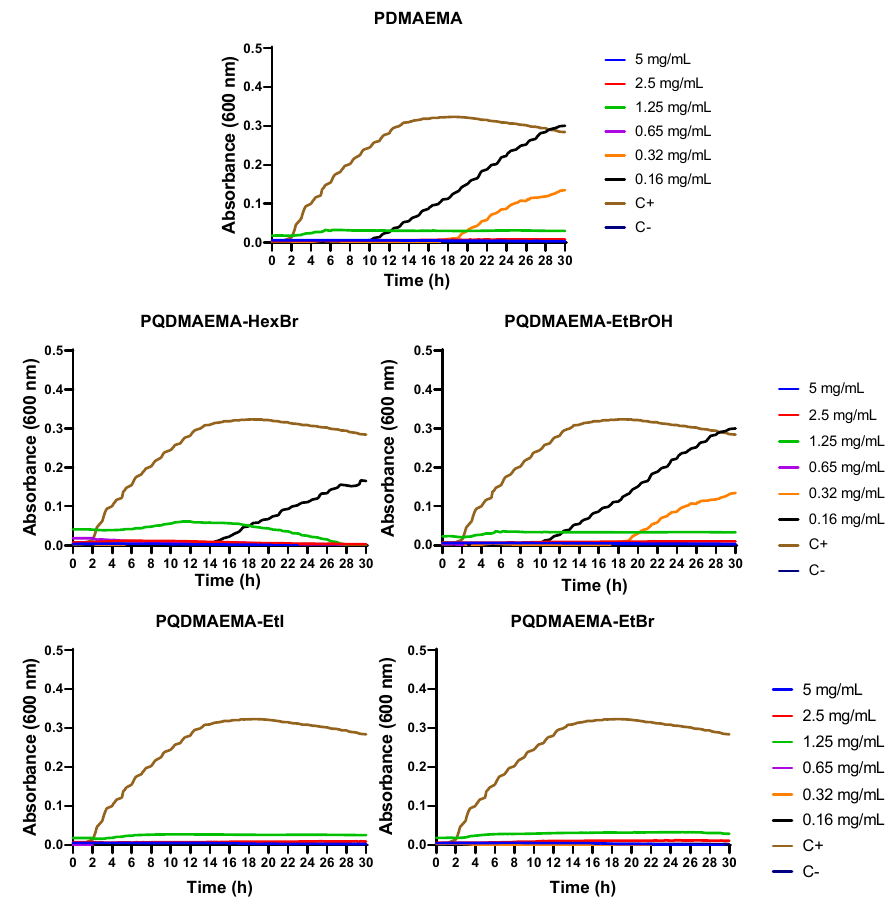
Figure 4. Growth kinetics of S. aureus in the presence of polymer concentrations ranging from 0.16 to 5 mg/mL. The optical densities were measured for 30 h incubation at 37 ◦ C using a multi-detection microplate reader at 600 nm and were automatically recorded for each well every 15 min. In all experiments, the bacterial suspension in pure LB and in the presence of amoxicillin/clavulanic acid were measured as the negative (C − ) and positive (C+) control, respectively.